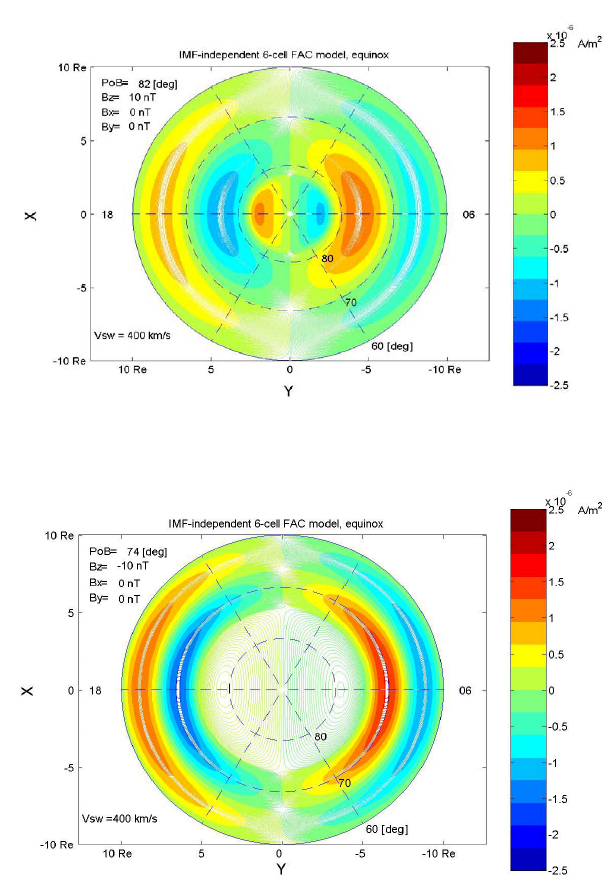
Fig. 3. FAC density variations in the polar cap (the dipole FAC structure), depending on the IMF B z component magnitudes, are illustrated. This figure depicts a six-cell, large-scale FAC system under equinox conditions where the IMF perpendicular component, B y , is assumed to be equal to zero. The coordinates are the same as in Fig. 2. Under negative IMF B z conditions (IMF B z equals to − 10nT) the initial six-cell FAC structure practically evolves into a four-cell FAC structure that occupies latitudes 60 ◦ –74 ◦ magnetic degrees only. Inversely, when the IMF B z is positive (IMF B z equals to 10nT) the six-cell FAC structure clearly emerges where the polar cap (dipole) FAC structure is of high